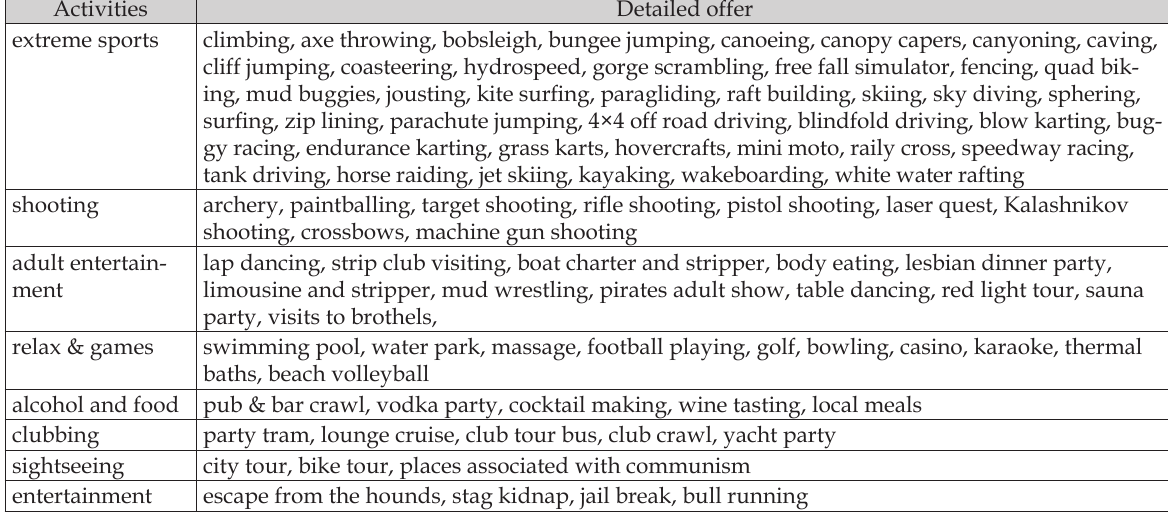
Table 3. Detailed stag weekend offer in European cities based on the analysed offers.